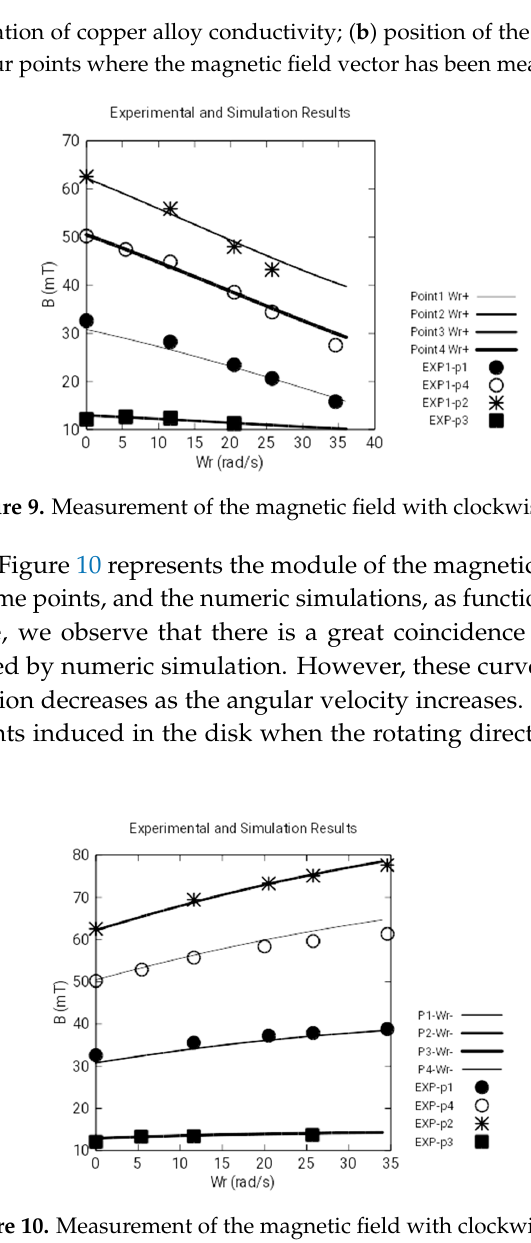
Figure 10. Measurement of the magnetic field with clockwise Wr+ .